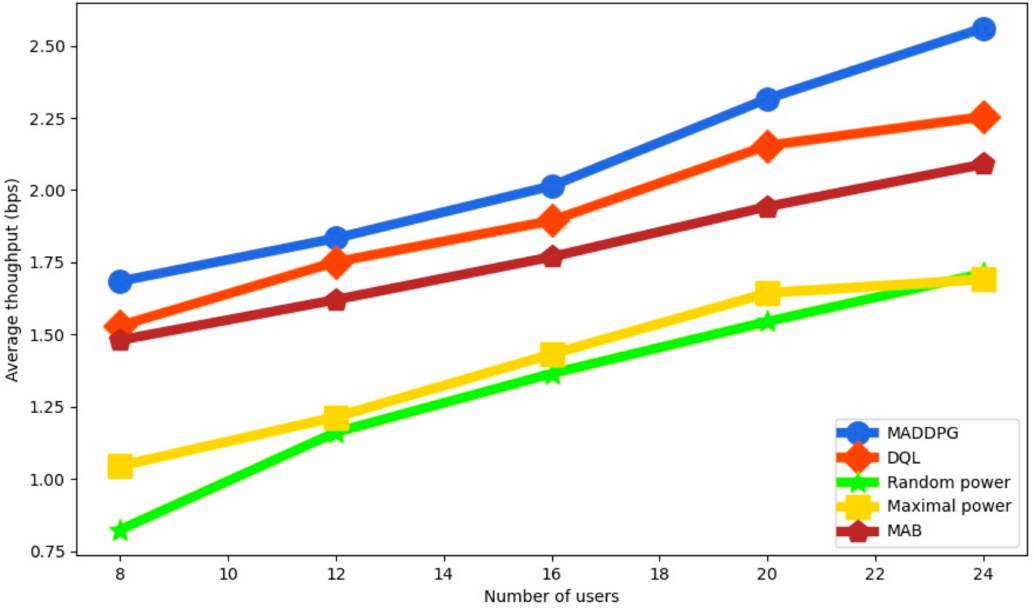
Figure 5. Average throughput as a function of the number of users with 4